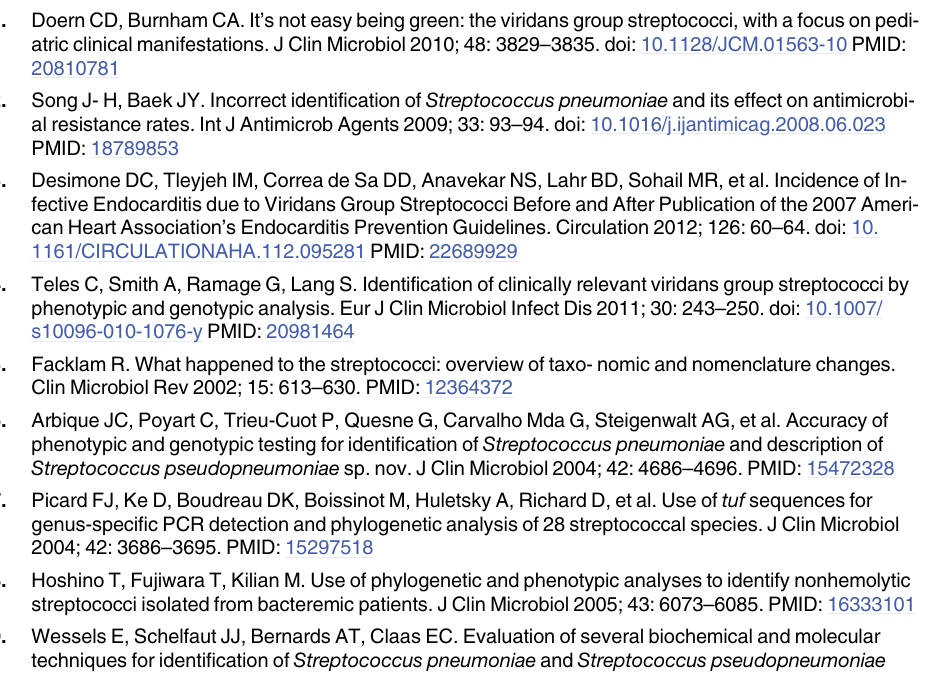
S1 Table. Phenotypic, molecular and MALDI-TOF characterization of VGS strains used in the